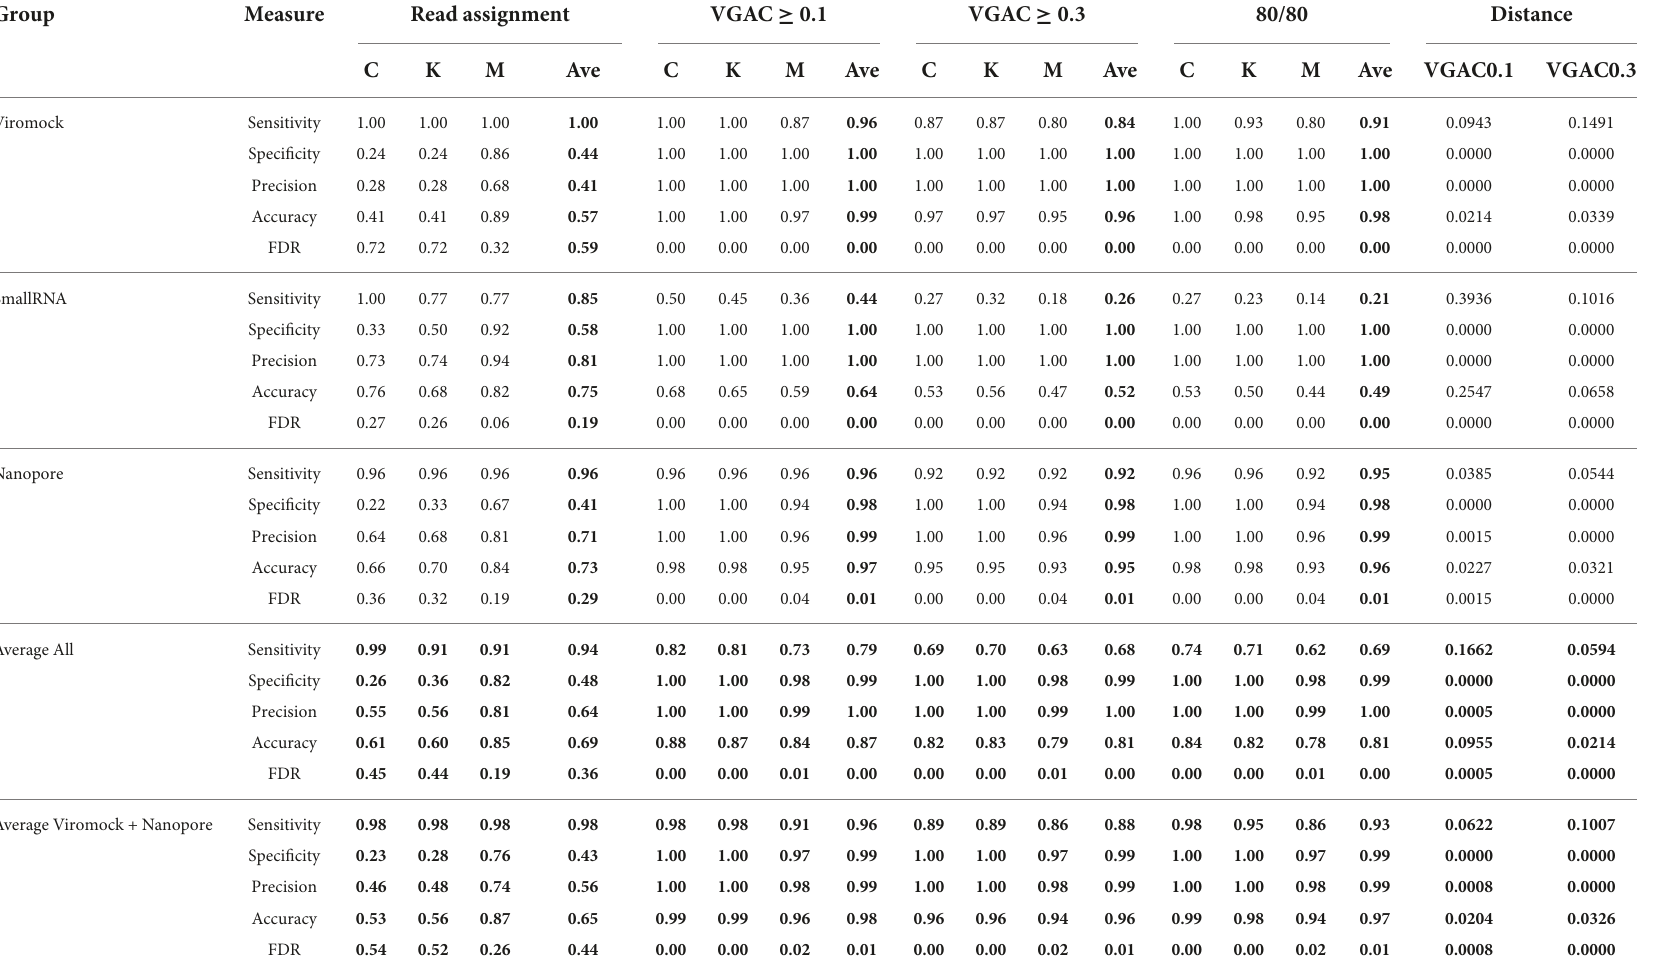
TABLE 2 Performance on external